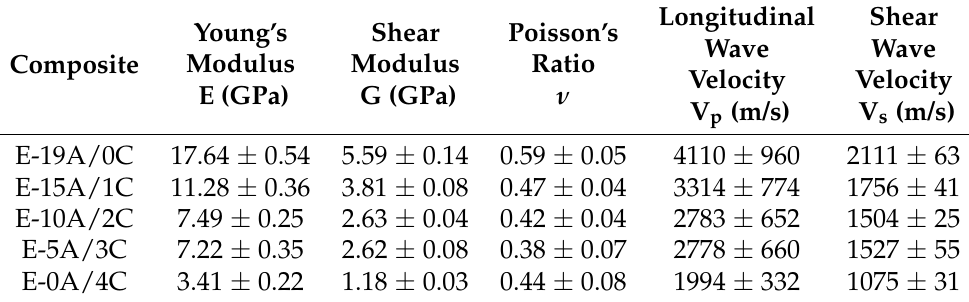
Table 8. Mechanical properties of composites obtained from the impulse excitation test.